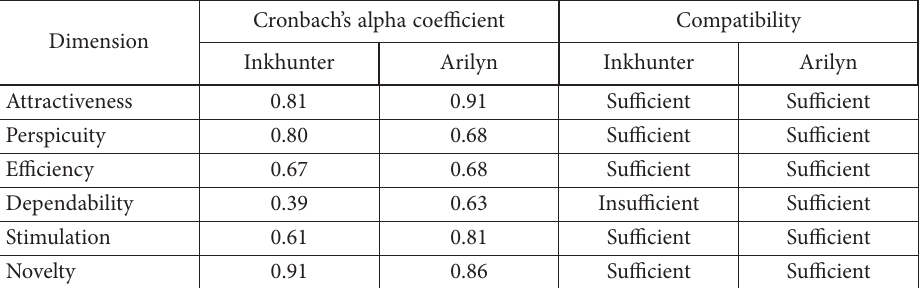
Table 3. Inner compatibility results of augmented reality applications Inhkunter and Arilyn (source: created by the authors) Dimension